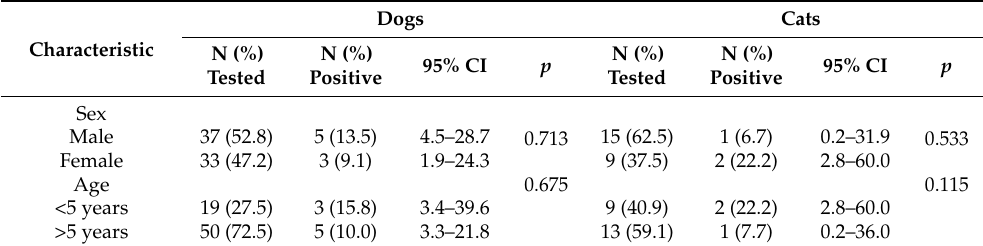
Table 4. Seroprevalence of Tahyna virus in pet animals according to sex and age.